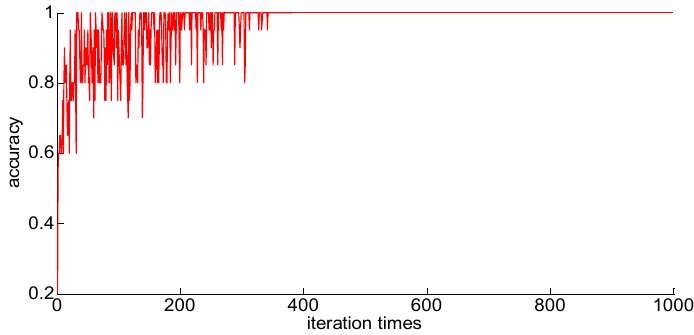
Figure 18. One hundred twenty-five training samples of the neural network.